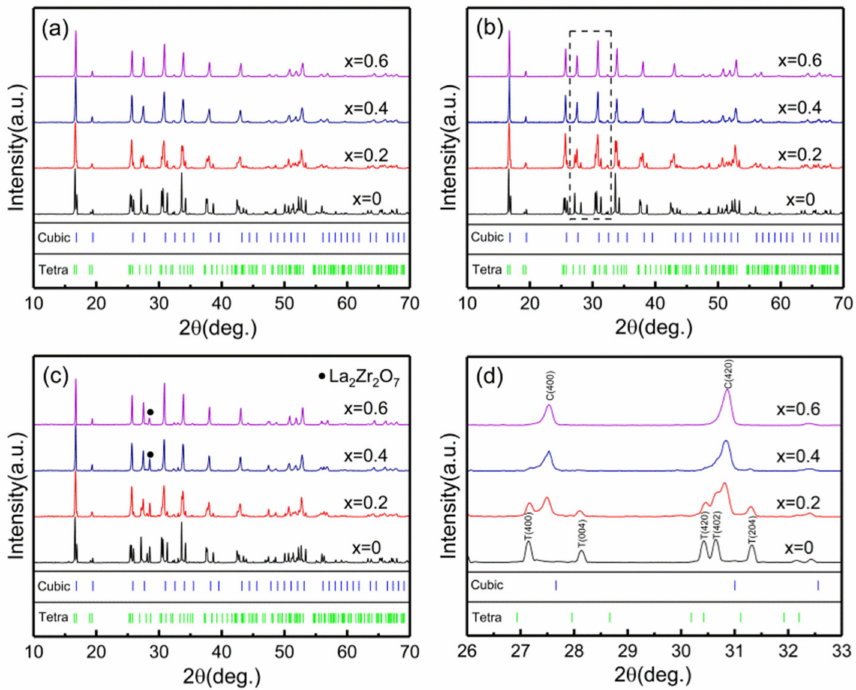
Figure 1. XRD patterns of LLZN x O (x = 0, 0.2, 0.4, 0.6) powder calcined at different temperatures for 10h. ( a ) 800 ◦ C, ( b ) 850 ◦ C, ( c ) 900 ◦ C. ( d ) Enlarged XRD patterns of LLZN x O (x = 0, 0.2, 0.4, 0.6) powder calcined at 850 ◦ C for 10 h from 26 to 33 ◦ .